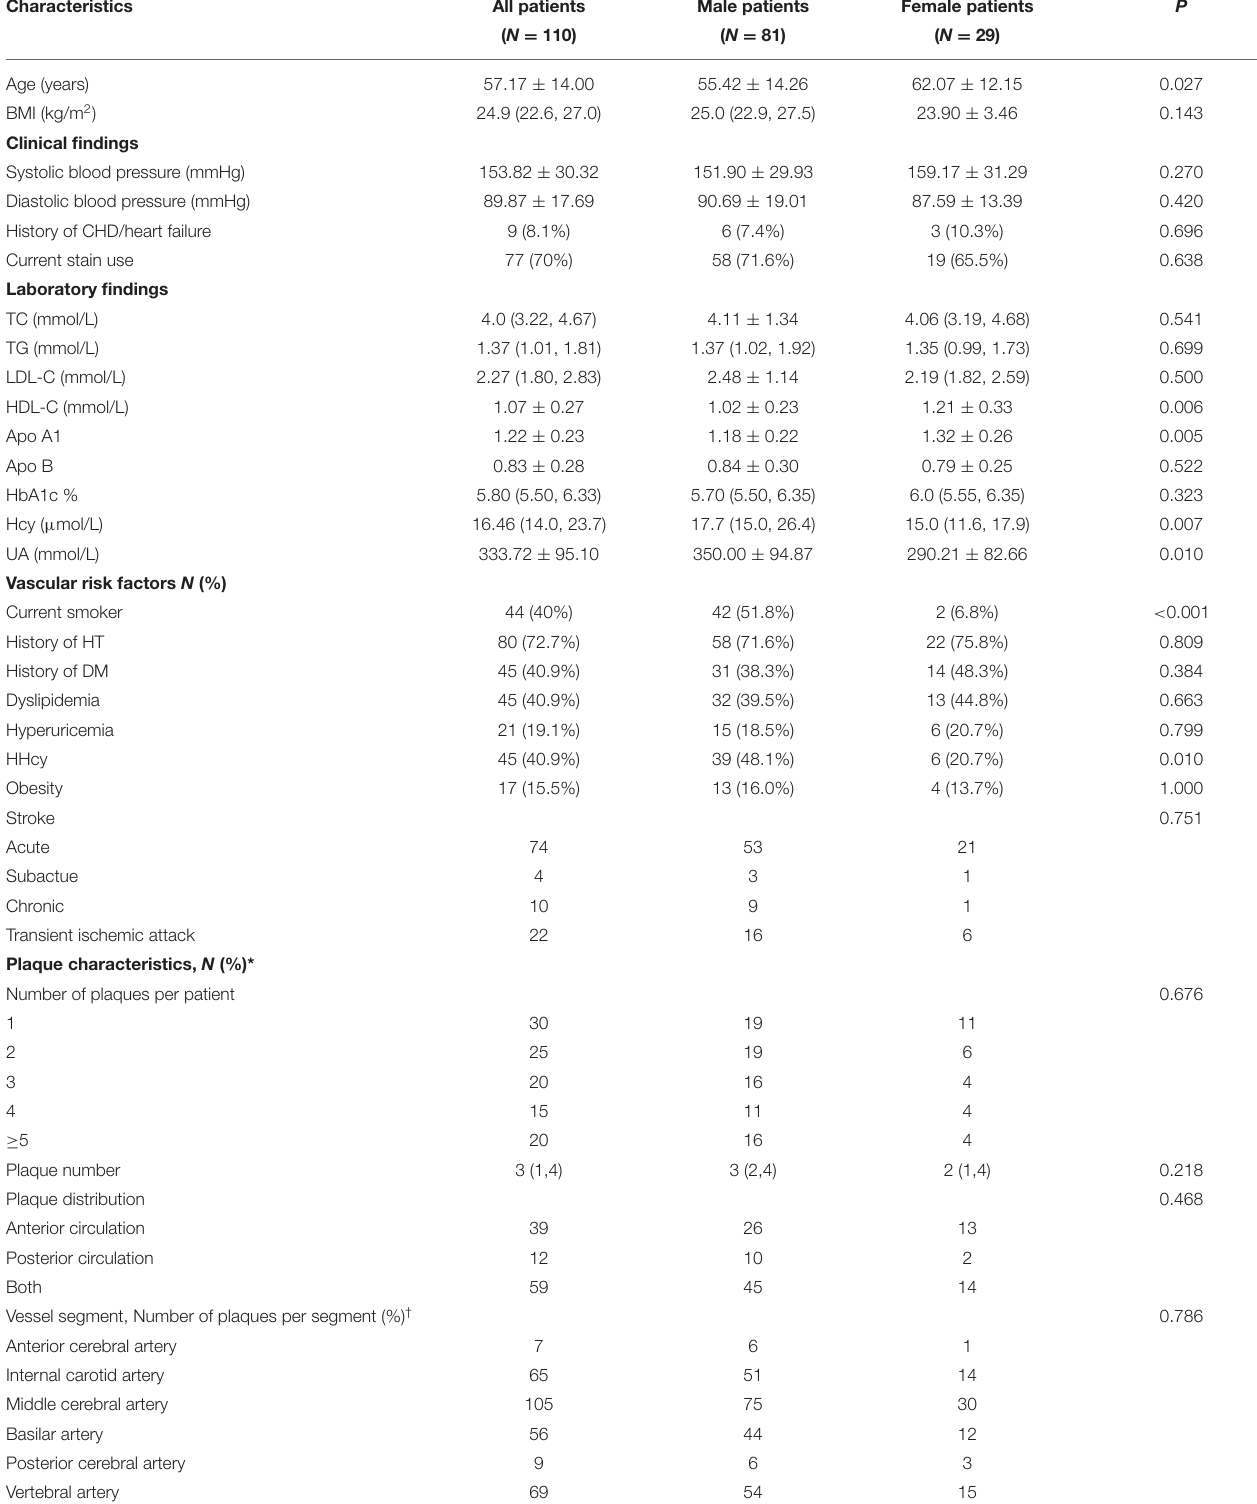
TABLE 1 | Differences in clinical data and plaque distribution between male and female patients.